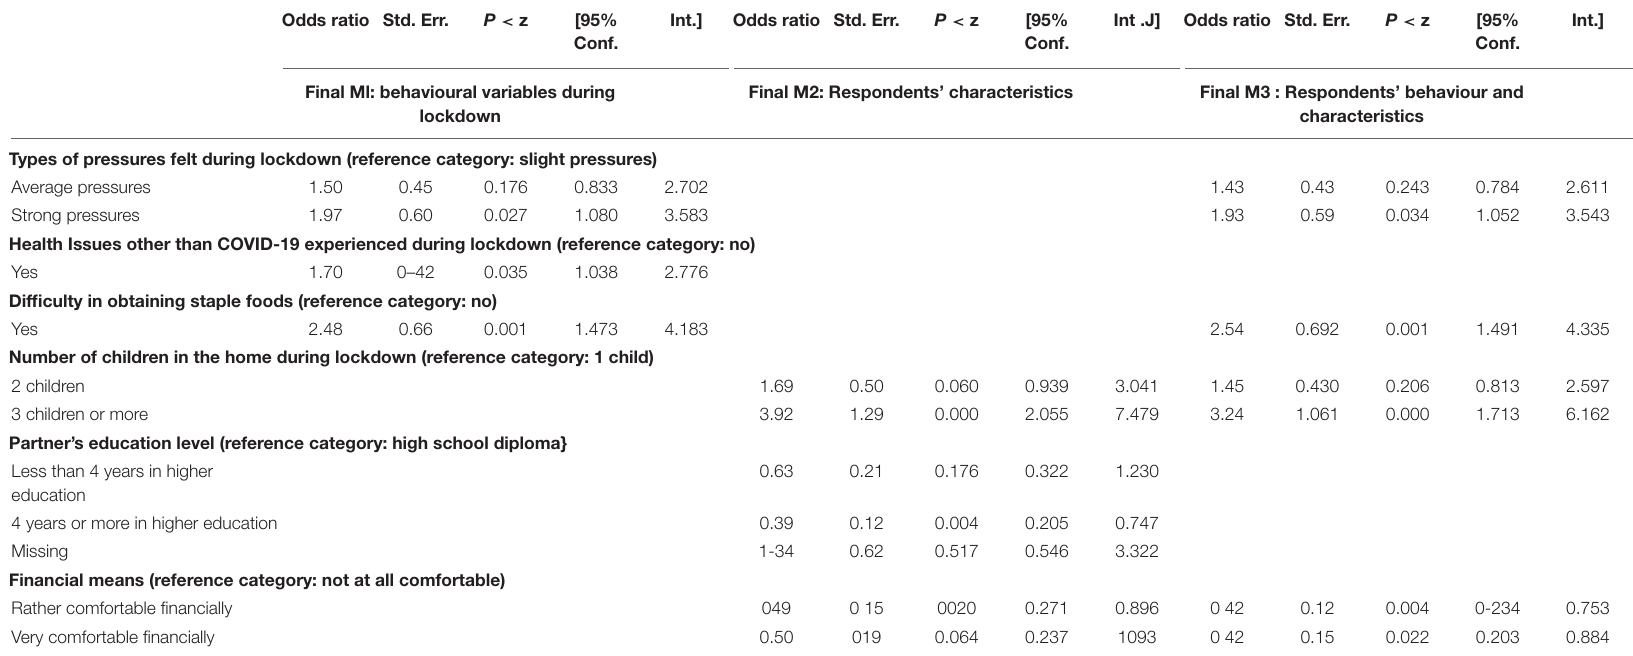
TABLE 3B | Multivariate models regarding the links between behaviours and characteristics of respondents and the presence of a child with a DD within the household during the first lockdown. Odds ratio Std. Err. P < z [95% Int.] Odds ratio Std. Err. P < z [95% Int .J] Odds ratio Std. Err. [95% Conf. Conf. Conf.